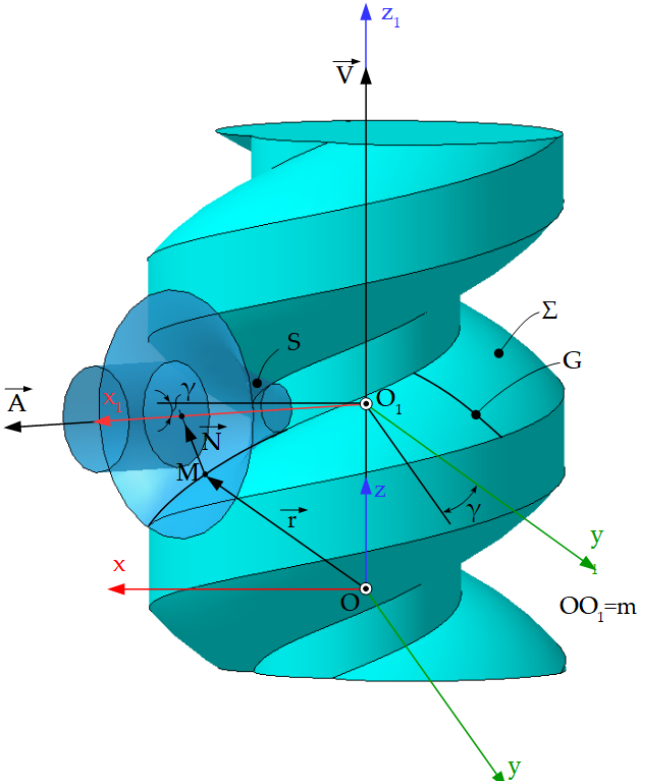
Figure 23. Generating with cylinder-front surface; reference systems: z represents the fixed reference system, with the z axis superimposed on the surface axis Σ ; xz 1 —fixed reference system, the x 1 axis being superimposed on the axis of the searched surface, S .